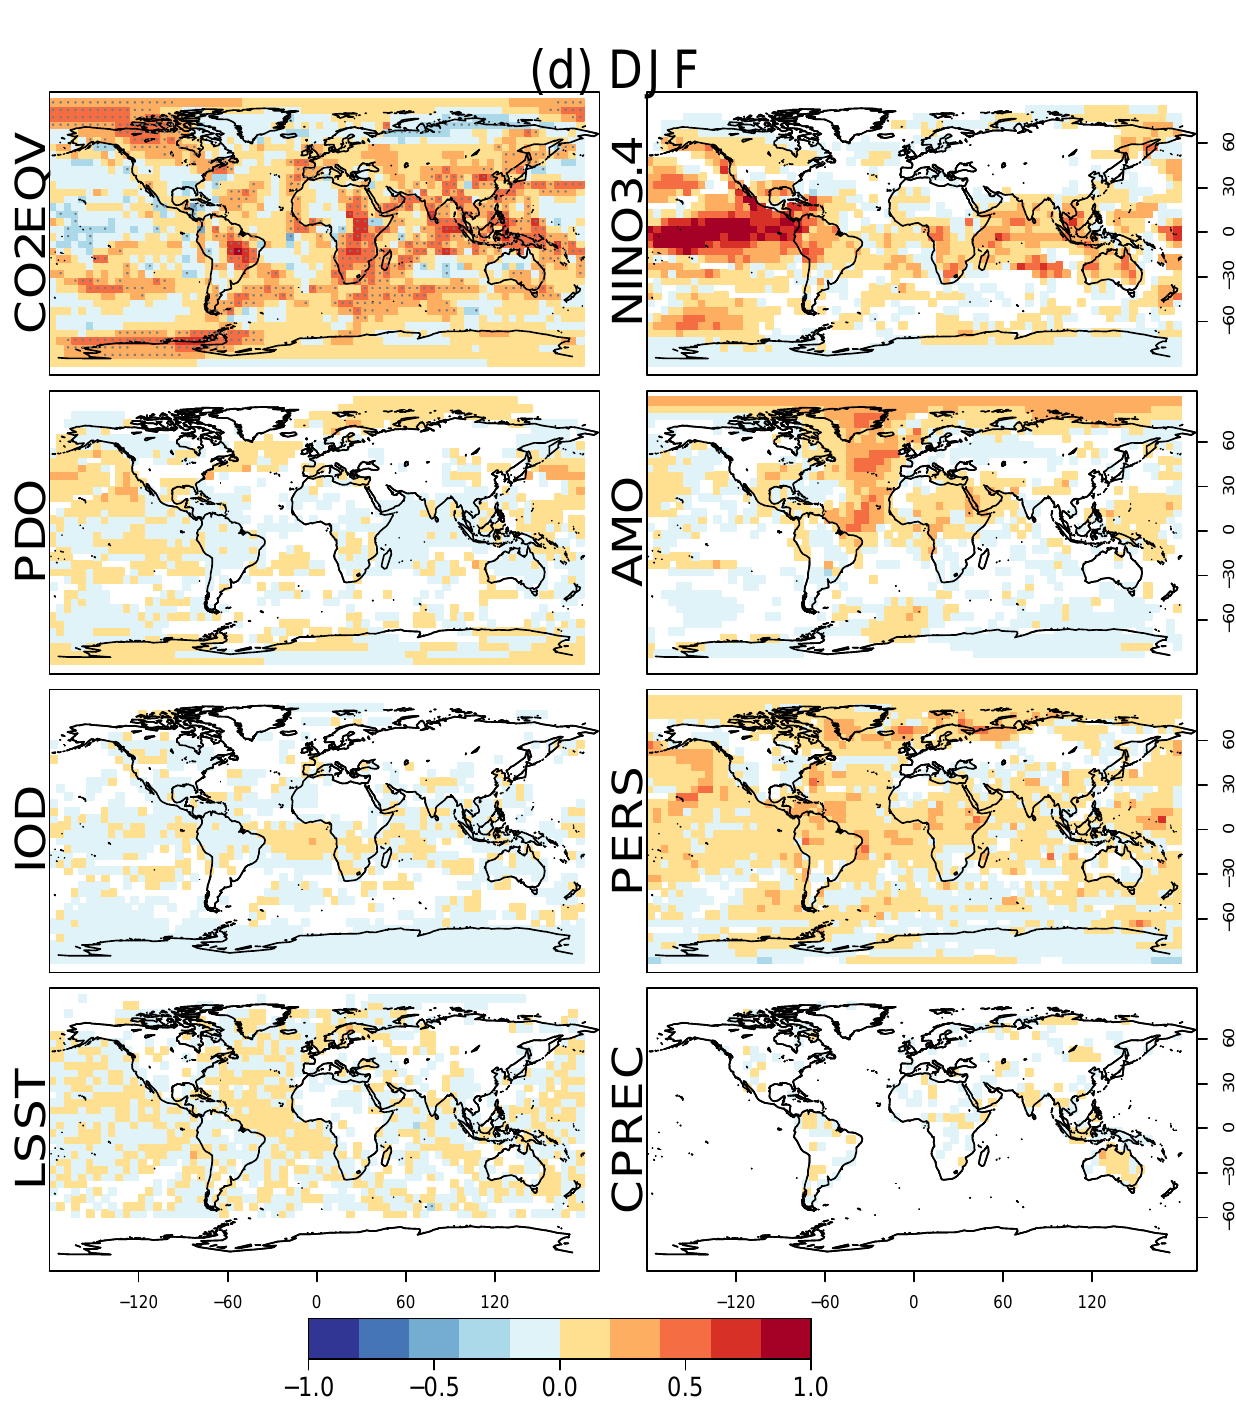
Figure 3. Correlation between SAT hindcasts and observations (1961–2013) for (a) MAM, (b) JJA, (c) SON, and (d) DJF. The top left panel shows correlation between observations and SAT hindcasts constructed using the CO 2 equivalent as the sole predictor; stippling is used to indicate significance at the 95% level. Subsequent panels show differences in correlation following the inclusion of additional